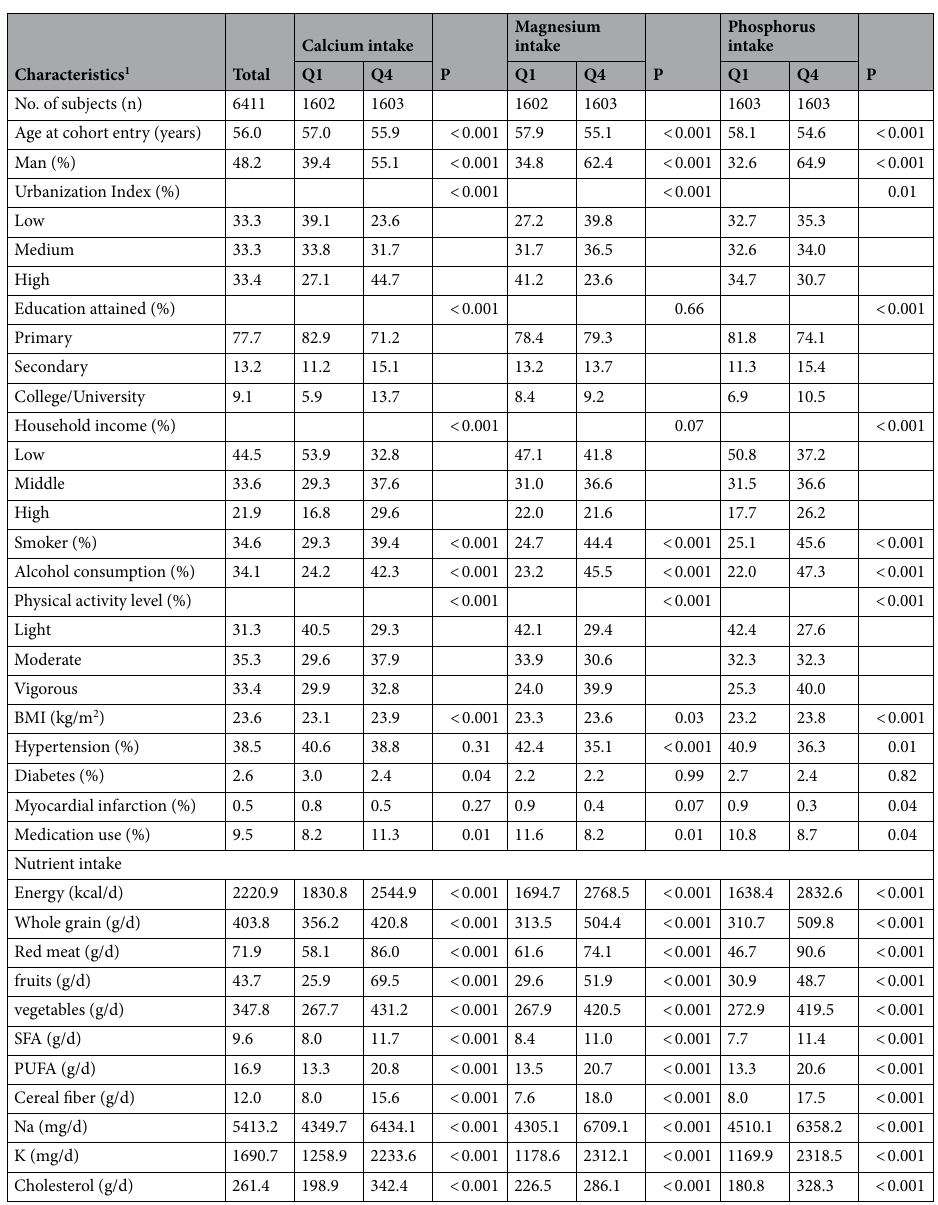
Table 1. Baseline characteristics of participants according to quartiles of dietary calcium, magnesium, and phosphorus intakes BMI, body mass index; SFA, Saturated fatty acid; PUFA, Polyunsaturated fatty acids. 1 Data are expressed as mean values for continuous variables or percentage (%) for categorical variables. The t-test is used for the continuous variables with normal distribution. The non-parametric test is applied to the continuous variables with non-normal distribution, and the chi-square test is used for the classified